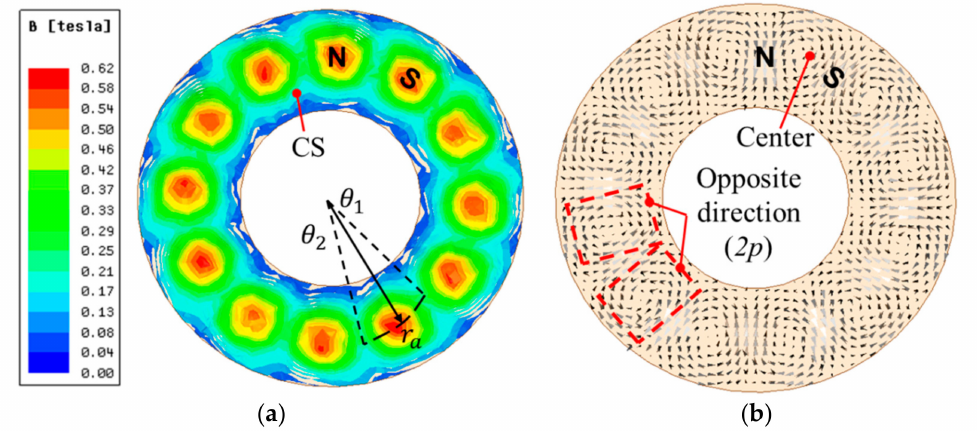
Figure 8. Magnetic field analysis ( z -axis, p = 6 and s = 50 r / min): ( a ) the magnetic flux density distributions, ( b ) the eddy current distributions.